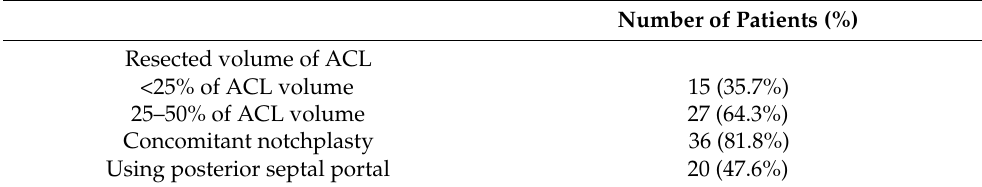
Table 3. Arthroscopic treatments of mucoid degeneration of the anterior cruciate ligament (MD-ACL) ( n =